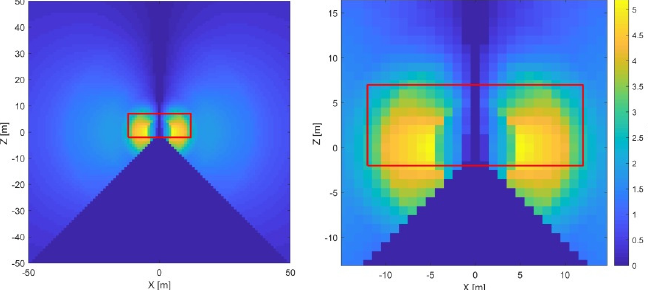
Figure 7. Signal to noise ratio (SNR) for 𝑥 (cid:2870) on a vertical plane—full field of view (left) and the close-up (right). The red square—the limitations of the cross-section dimensions of the facility used in the empirical experiment.